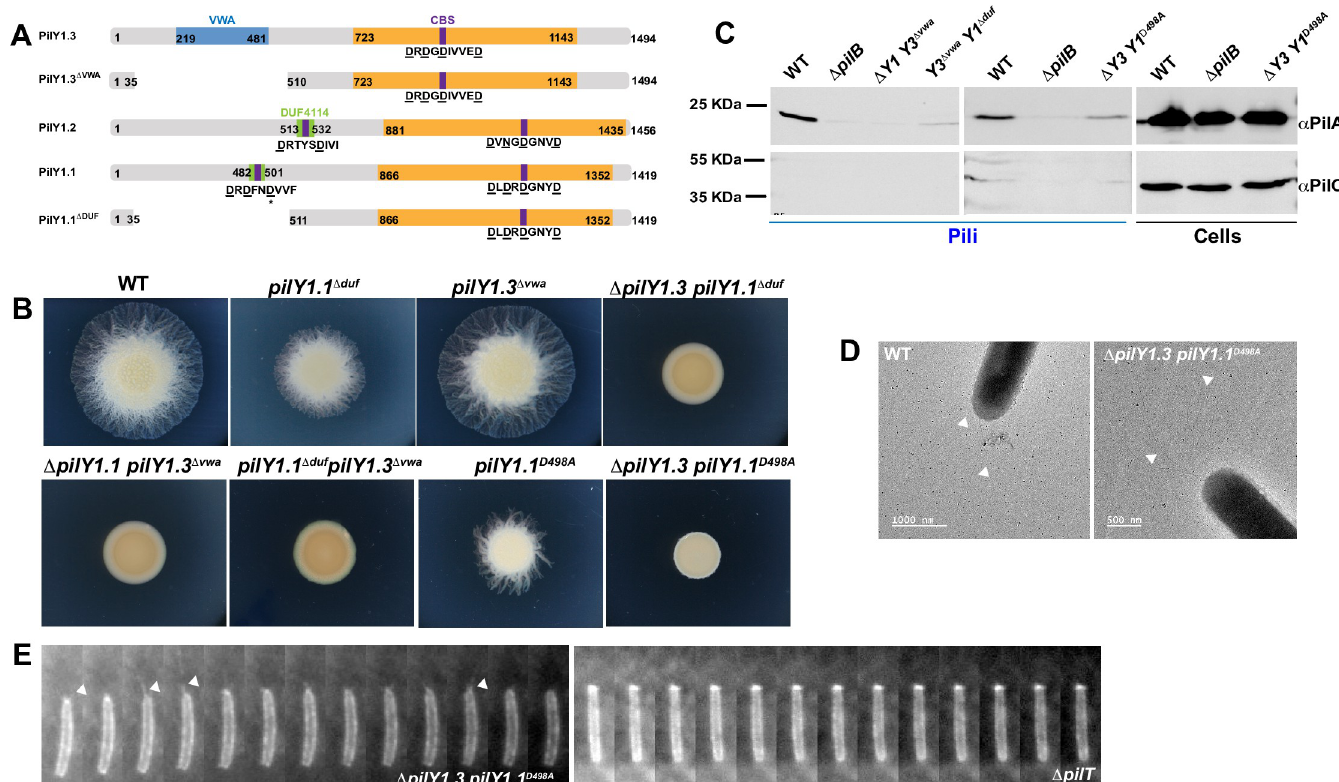
Fig 7. The C-terminal region of PilY1.1 and PilY1.3 is essential for T4P assembly. (A) Schematic representation of PilY1 proteins. Numbers at each side of the grey bars indicates the length of protein fragments. CBS (purple) stays for Calcium Binding Sites; VWA for Von Willbrand factor A (blue); DUF (green) stays for DUF4114; the conserved PilY1 domain is indicated in orange. The letters indicate the conserved protein sequences. The underlined amino acids indicate a consensus for a given motif. The star � corresponds to the conserved active D498 of PilY1.1. (B) Motility phenotypes of DZ2 (wild type), EM901 ( pilY1 . 1 Δ duf ), EM898 ( pilY1 . 3 Δ vwa ), EM902 ( Δ pilY1 . 3 pilY1 . 1 Δ duf ), EM897 ( Δ pilY1 . 1 pilY1 . 3 Δ vwa ), EM909 ( pilY1 . 1 Δ duf pilY1 . 3 Δ vwa ), EM937 ( pilY1 . 1 D498A ) and EM938 ( Δ pilY1 . 3 pilY1 . 1 D498A ) on 0.5% agar and pictured at 48H. (C) Western blot detection of PilA and PilC in sheared-off T4P and total cell lysate of the indicated strains and using DZ2 (wild type) and EM747 ( Δ pilB ) as positive and negative controls, respectively. Membranes were probed with α PilA antibodies (top rows) and α PilC antibodies (bottom rows). (D) TEM micrographs of the indicated strains. Arrowheads indicate T4P on the cell surface. (E) 5s time-lapse series, obtained by TIRF microscopy, of labeled T4P pilin filaments and polar cluster enrichment of the indicated strains bearing att mx8 ::P pilA -pilA D71C